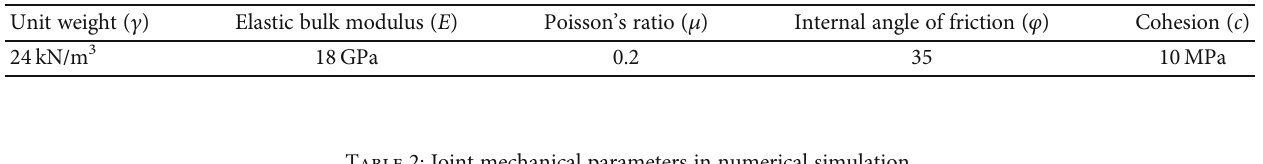
Table 1: Block and joint mechanical parameters in numerical